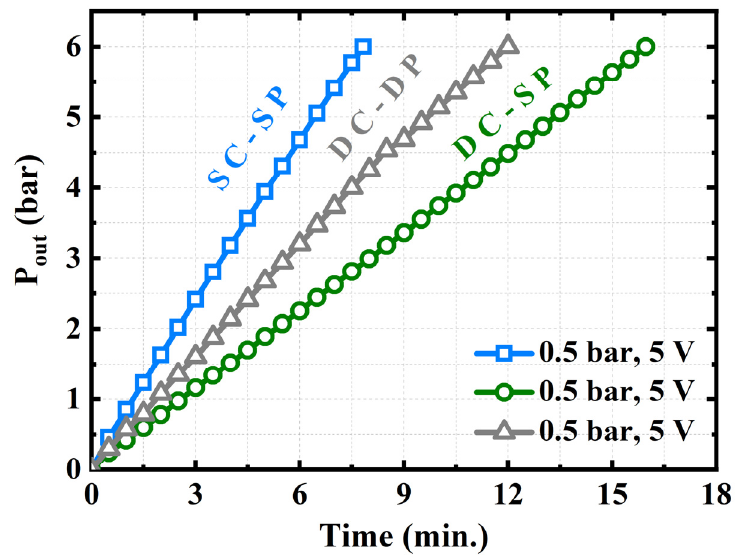
Figure 7. Comparison between the three experimental setups .